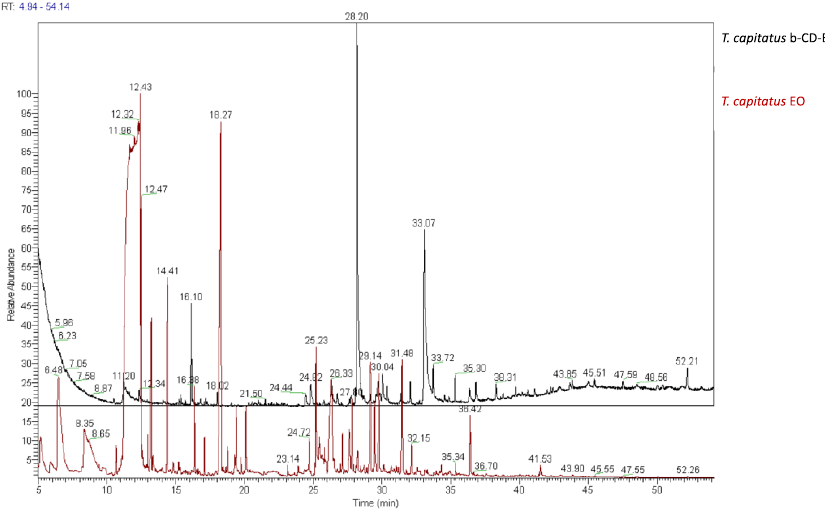
Figure 5. GC-MS chromatograms of T. capitatus EO (red line) and T. capitatus solid-state b-CD–EO-T (black line) samples.